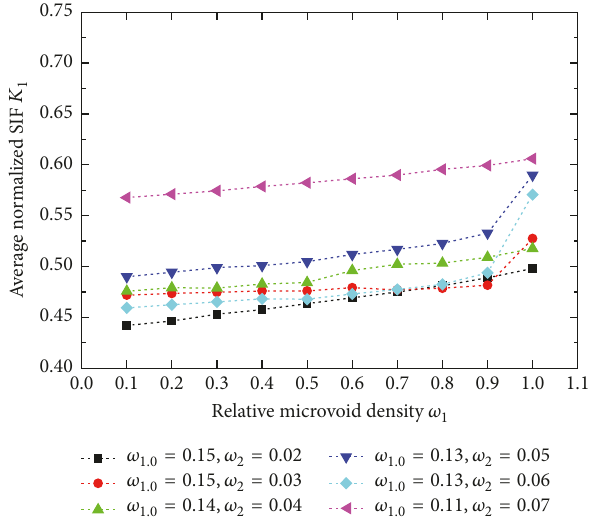
Figure 17: Average 𝐾 1 versus relative microvoid